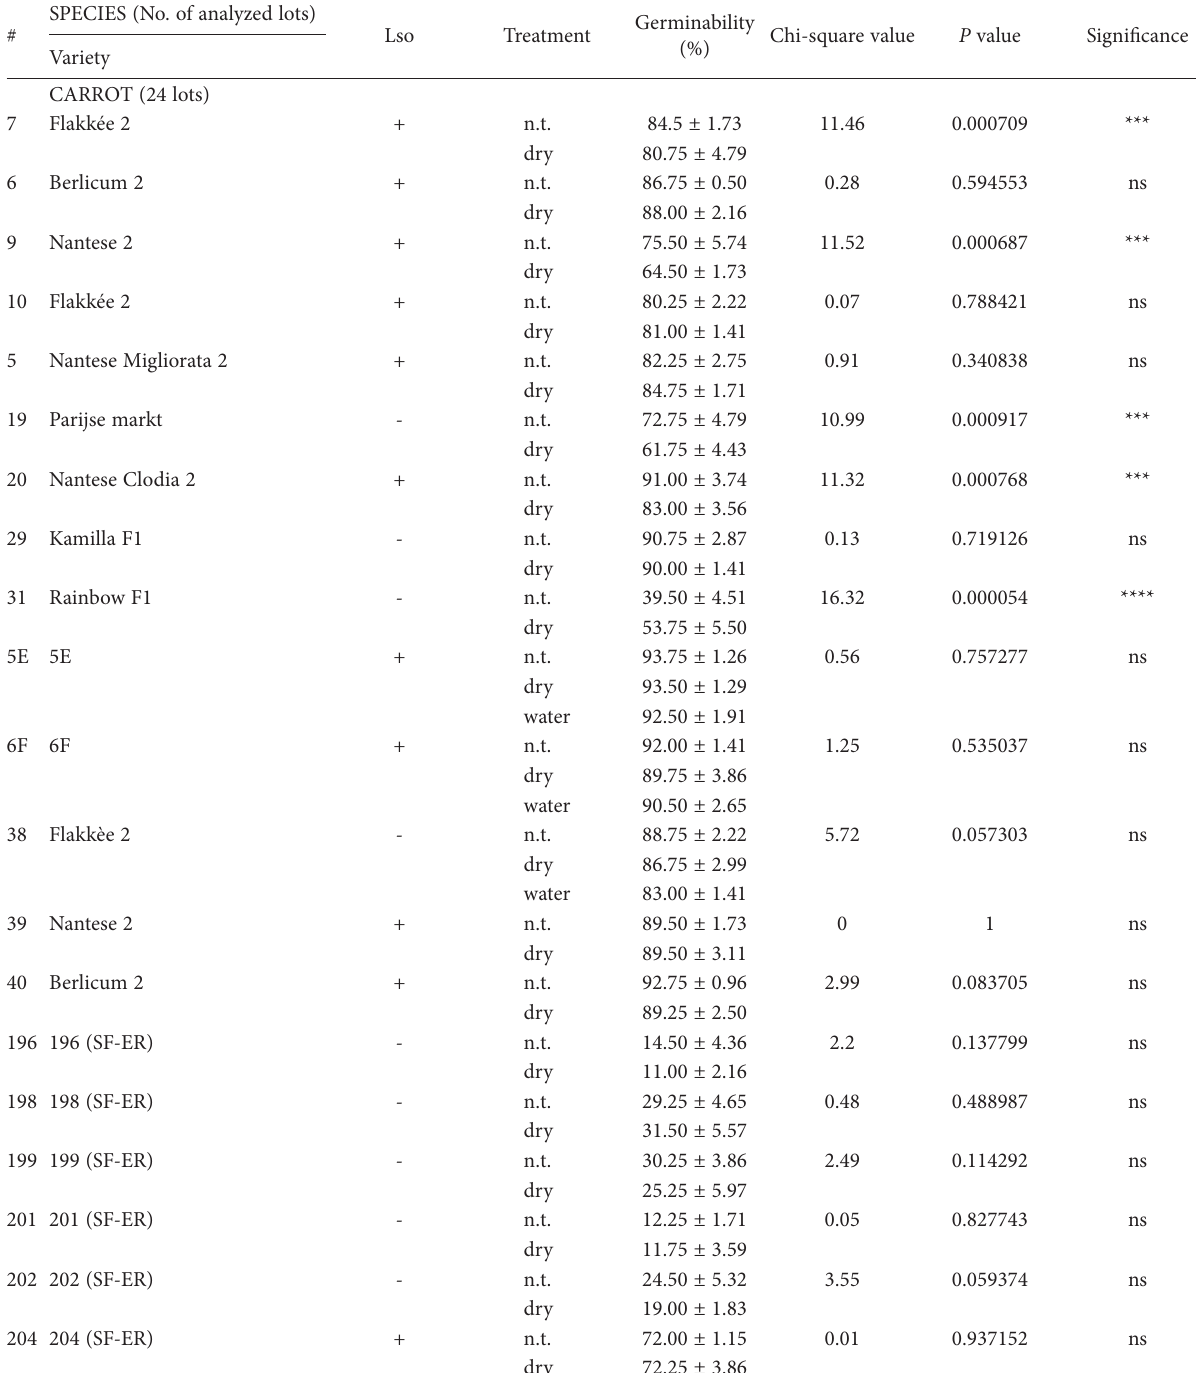
Table 1a. Seed lots used in experiments, their germination rates after treatments (n.t. = no treatment, dry = dry heat treatment, water = water heat treatment), Chi-square and P values obtained by Chi-square tests. Germinability values are expressed as means ± standard deviations of n = 400 seeds. Significant differences (Chi-square tests) are indicated by * = P < 0.05, ** = P < 0.01, *** = P < 0.001, **** =